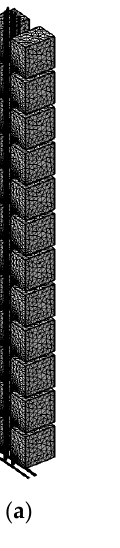
Figure 2. ( a ) System mesh grid generation. ( b ) Mesh generation over units.